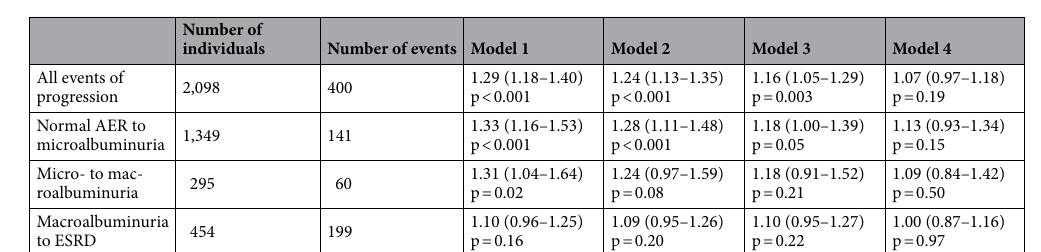
Table 2. Cox proportional hazards analysis with different levels of adjustment for DKD progression. Hazard ratios (HRs) are presented for a 10-unit increase in H-ficolin concentration. Model 1: Unadjusted. Model 2: Diabetes duration and sex. Model 3: Model 2 + HbA 1c , systolic blood pressure, and smoking status. Model 4: Model 3 + triglycerides.